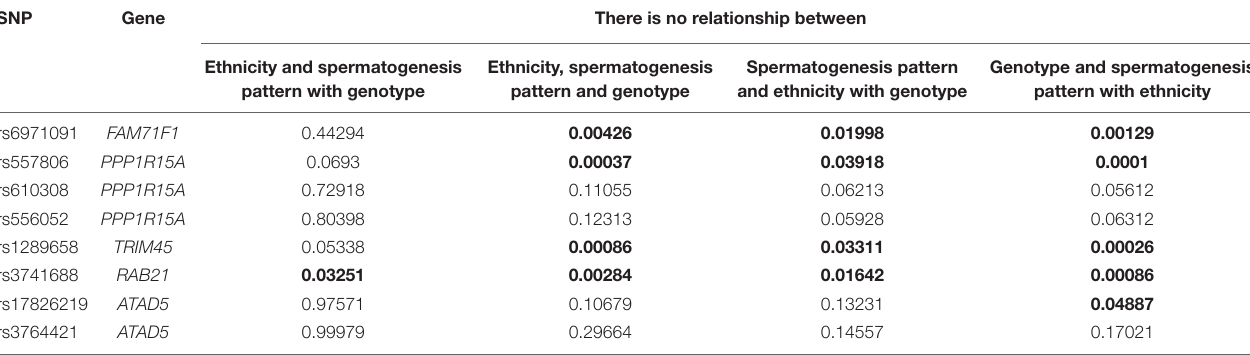
TABLE 2 | Results of χ 2 tests for pairwise independence of the spermatogenesis pattern, genotype, and ethnicity of top polymorphisms with high or moderate impact based on VEP results in the joint set ( p -value < 10 − 3 ) localized in the genes expressing in testis ( > 1NX). SNP Gene There is no relationship between Ethnicity and spermatogenesis pattern with